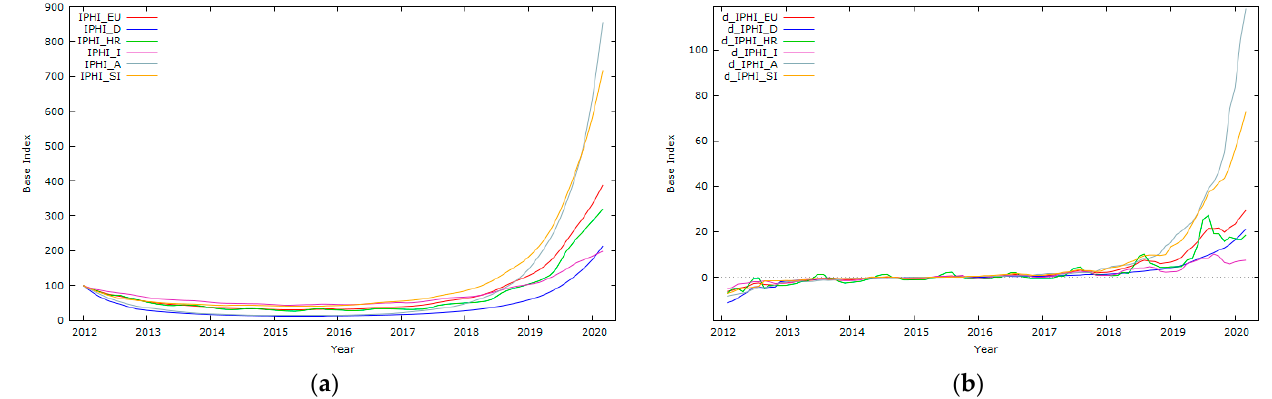
Figure A2. ( a ) Distribution of food and beverages price indices for Austria, Croatia, Germany, Italy, and Slovenia; ( b ) Distribution of 𝐼(1) food and beverages price indices for Austria, Croatia, Germany, Italy, and Slovenia. Note. IFB—Food